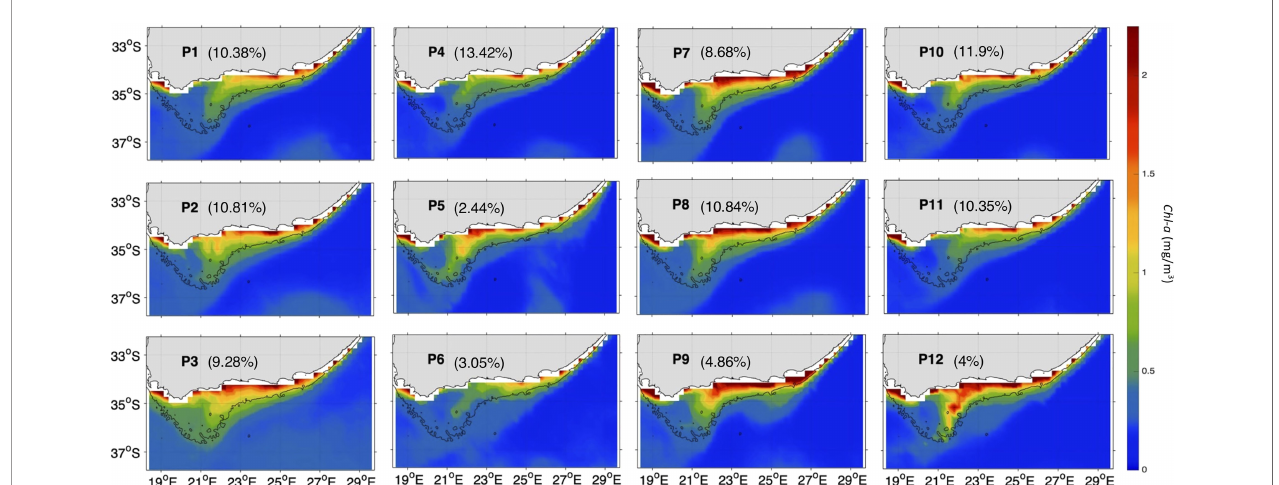
FIGURE 4 | The 12 characteristic Chl-a (in mg/m 3 ) patterns (P1 to P12) over the Agulhas area of interest (orange box, Figure 1 ) during Nov-Mar 97-20 as derived from the 3x4 SOM. The currents vectors are plotted with the same length, so the direction of the currents is clearer. The currents speed can be seen from the colormap. The percentages between parentheses represent the frequency of occurrence of each pattern. The 200m isobath marking the continental shelf is highlighted with a black solid line.